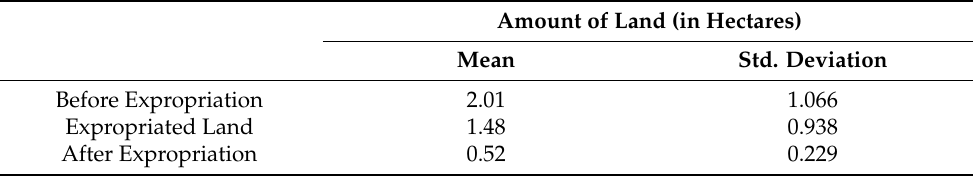
Table 1. Average landholding before and after expropriation. Amount of Land (in Hectares) Mean Std. Deviation Before Expropriation 2.01 1.066 Expropriated Land 1.48 0.938